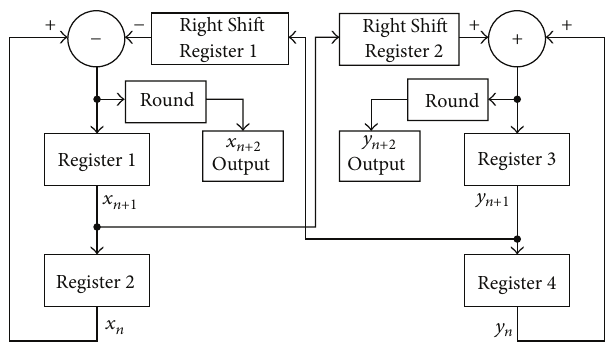
Figure 3: Functional diagram for the circular interpolator